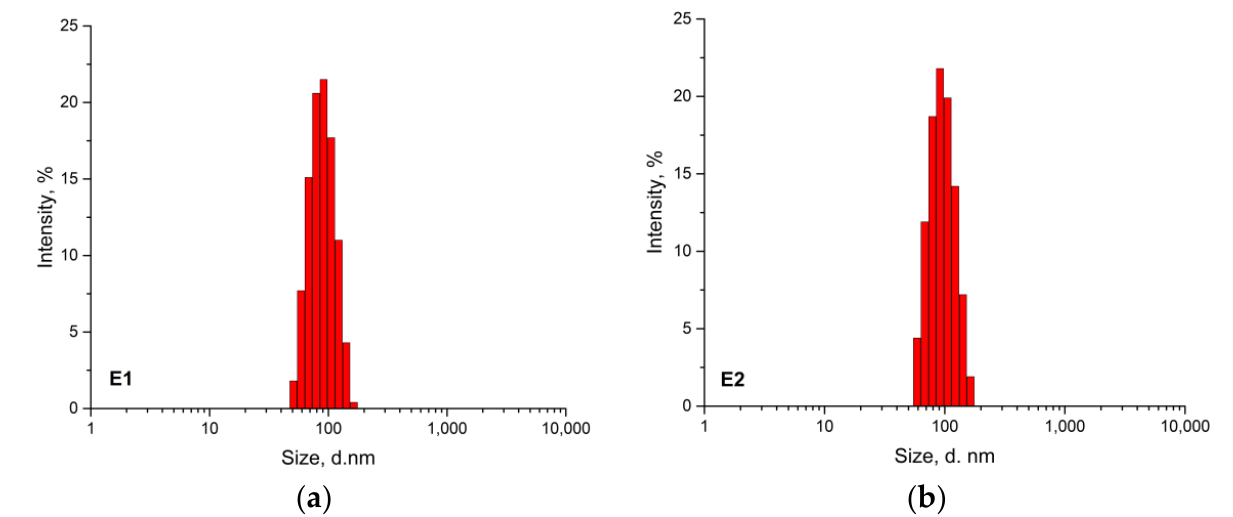
Figure 1. The particle size distribution of the latexes ( a ) E1-random copolymer latex; ( b ) E2-composite copolymer latex. Table 3. Average particle size diameters, polydispersity index and zeta potential values of the la- texes.